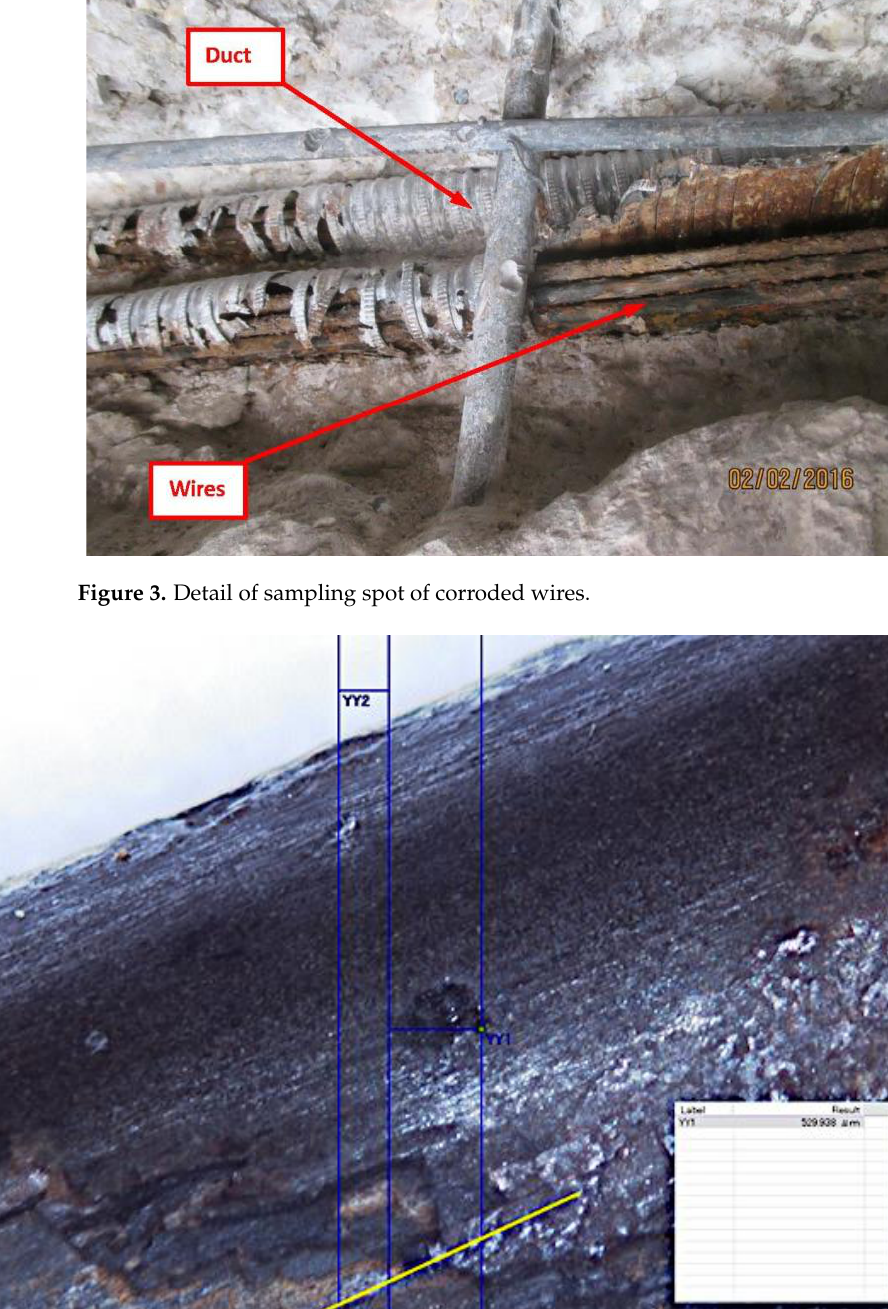
Figure 2. Sampling spot of corroded wires with 40-mm diameter ducts.